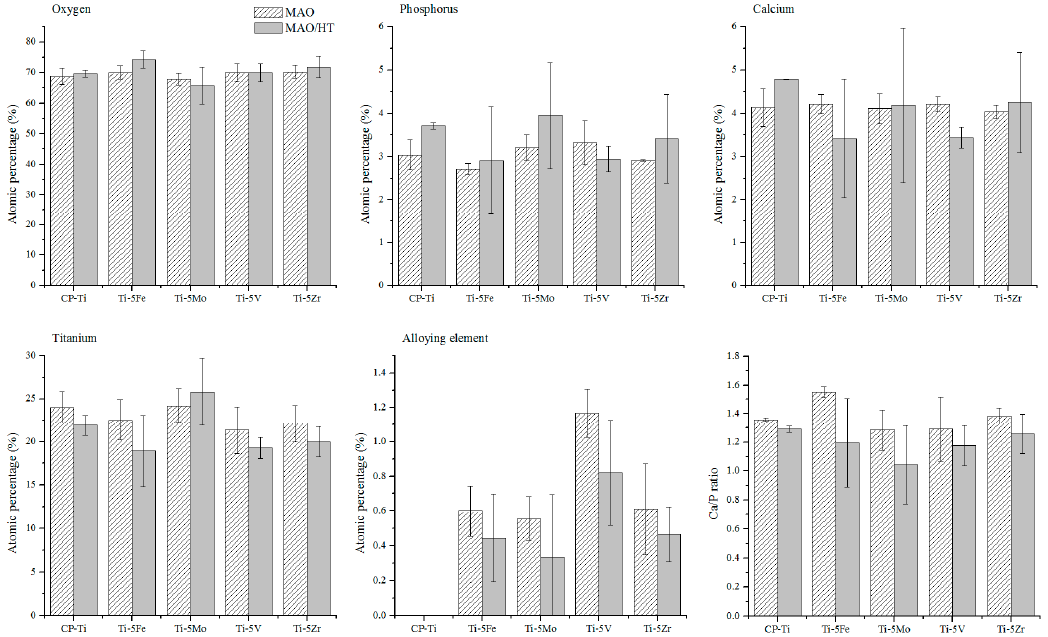
Figure 5. Energy dispersive X ‐ ray spectroscopy (EDS) elemental content of MAO ‐ and MAO/HT ‐ treated samples.